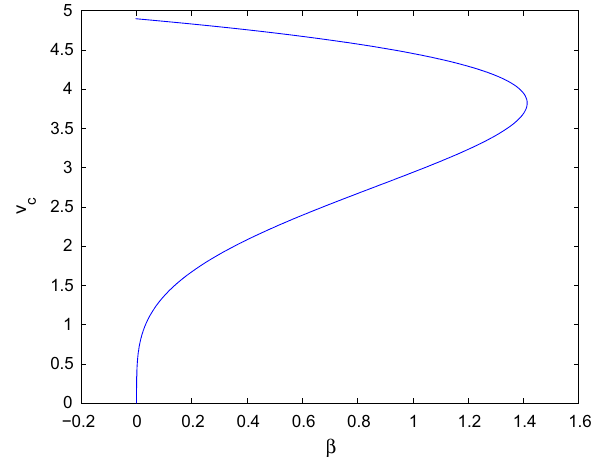
Fig. 4 The plot of the function v c vs β at q m = 1